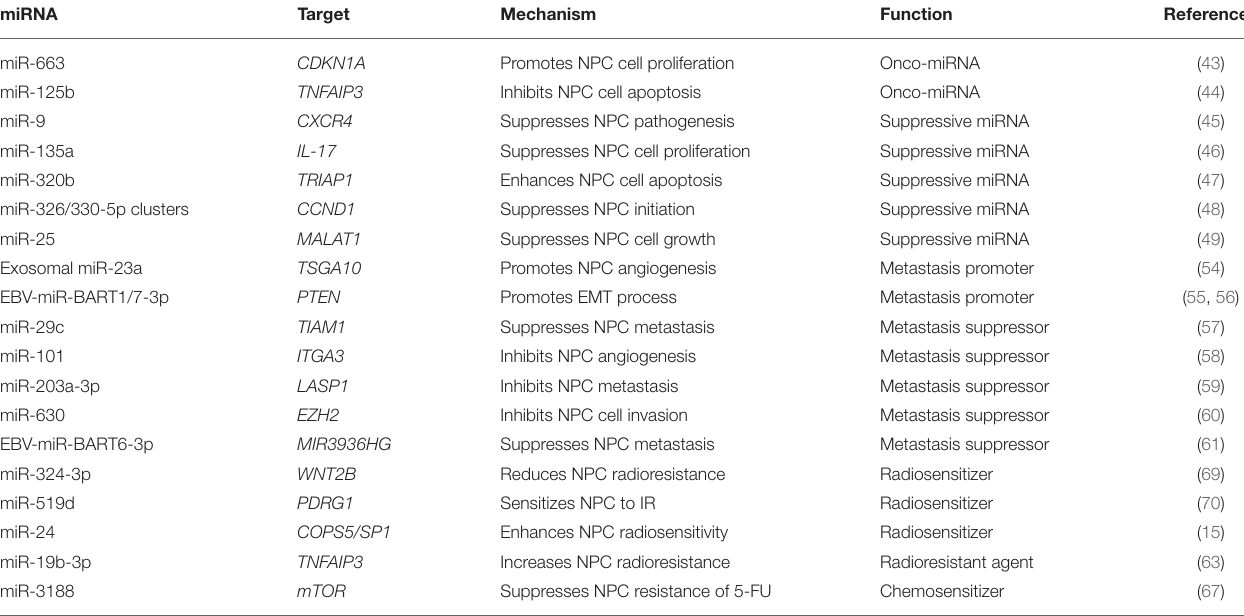
TABLE 1 | miRNA dysregulation in NPC initiation, progression and therapies.